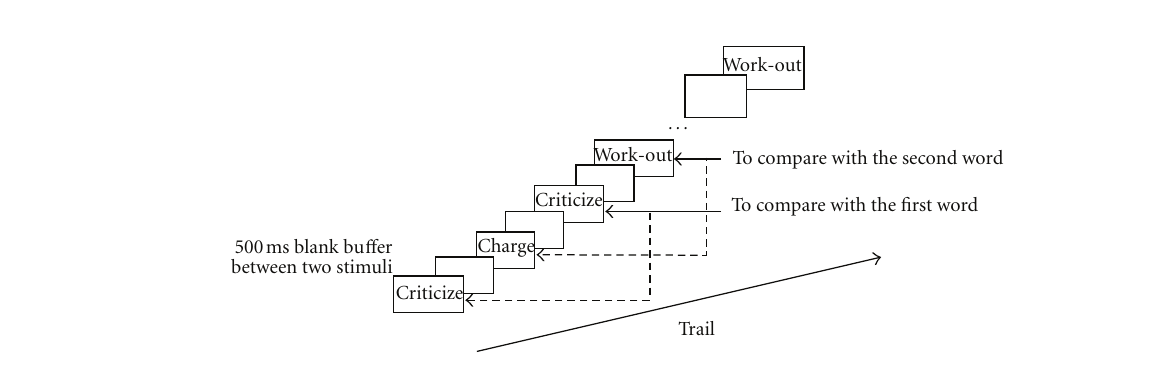
Figure 2: The procedure of 2-back task